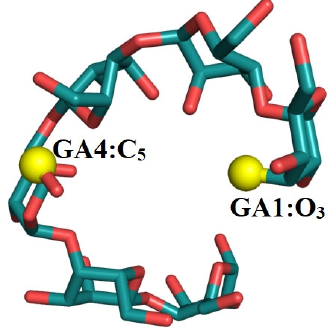
Figure 5. Atom distance between the O 3 atom in the residue x and the C 5 atom in the residue x+3, the two yellow atoms are O 3 and C 5 , respectively.